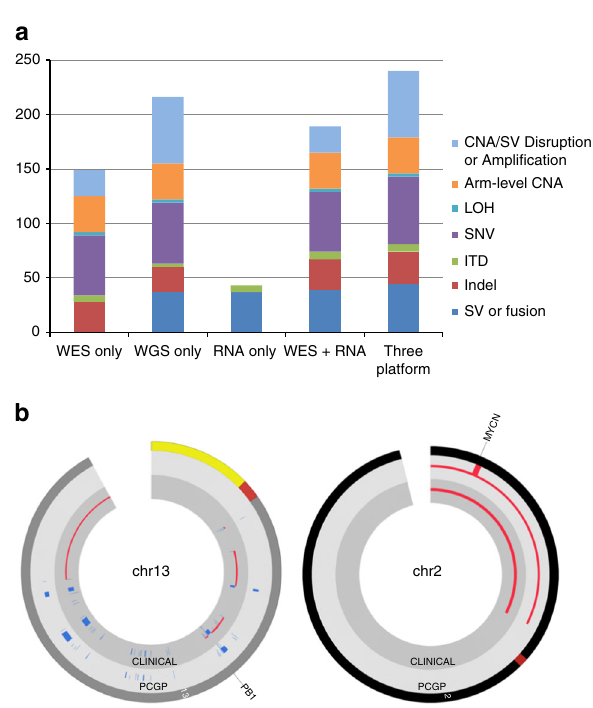
Fig. 5 Detection of pathogenic or likely pathogenic variants by three- platform sequencing. a Number of variants detected by each platform either alone or in combination. b Comparison of copy number alterations detected by PCGP (outer circle) and three-platform sequencing (inner circle). The left CIRCOS plot depicts the CNAs detected on chromosome 13 showing near-perfect agreement between the samples analyzed by PCGP and three-platform sequencing. The right CIRCOS plot depicts chromosome 2, where a MYCN amplicon was detected only in the PCGP